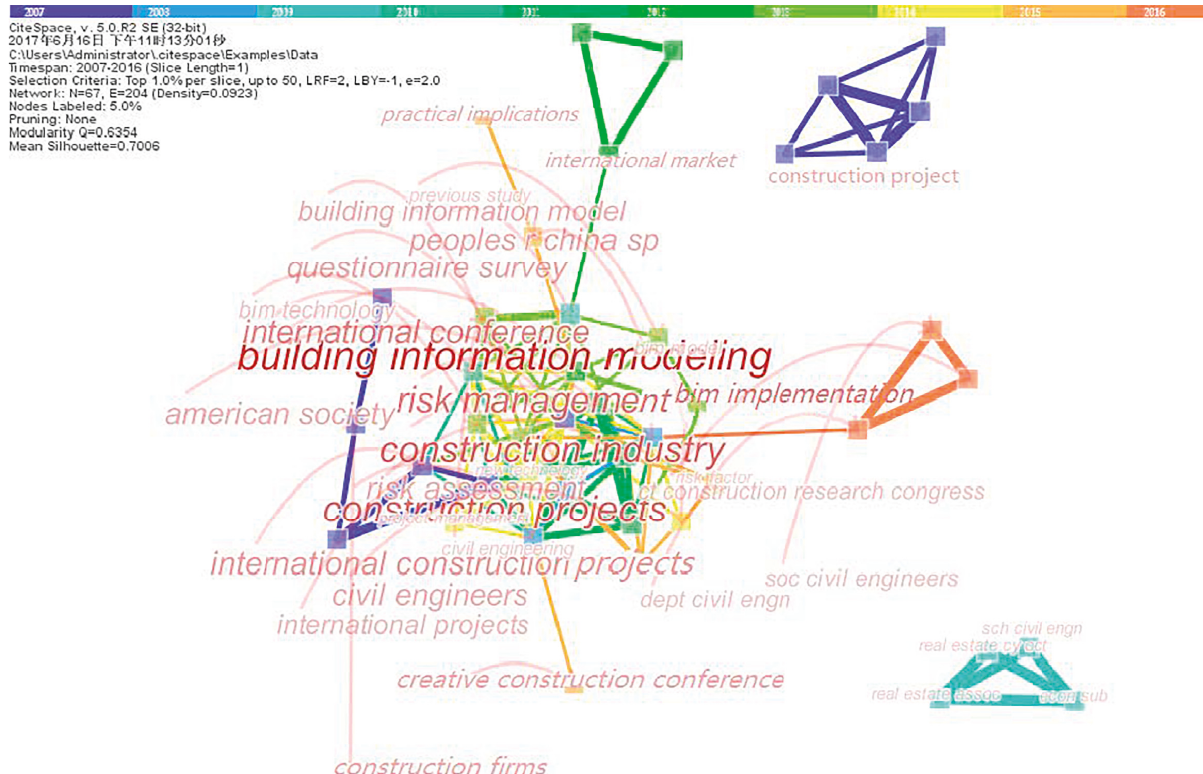
Figure 4: (Extracted) keyword cooccurrence